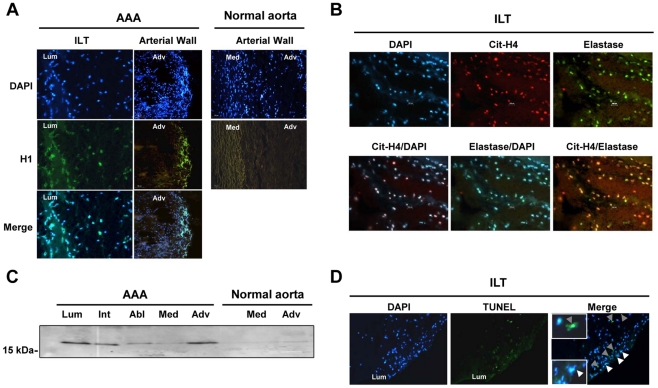
Characterization of neutrophil extracellular traps (NETs) in human AAA samples.The presence of NETs in AAA intral-luminal thrombus (ILT) and in aneurysmal wall was demonstrated by co-immunostaining of histone H1, citrullinated histone H4 (cit-H4) and elastase. Nuclei were stained with DAPI (100 ng/ml, 15 minutes). (A) Immunostaining for histone H1 (green) showing destructured nuclei in the luminal (lum) part of ILT as well as in the adventitia (Adv). (B) Immunostaining for cit-H4 and elastase demonstrates specific neutrophil activation prior to DNA expulsion. (C) The release of cit-H4 was analyzed by western blot in the conditioned medium from the different layers of ILT (luminal: Lum, intermediate: Int and abluminal: Abl) and of the remaining aortic wall (media: Med and adventitia: Adv). (D) Terminal-transferase dUTP Nick End Labelling (TUNEL) staining in the luminal part of ILT (green). TUNEL-positive cells are indicated by grey arrowheads. Extracellular nucleosomes (NETs) are indicated by white arrowheads. Merged images were obtained using Archimed software.